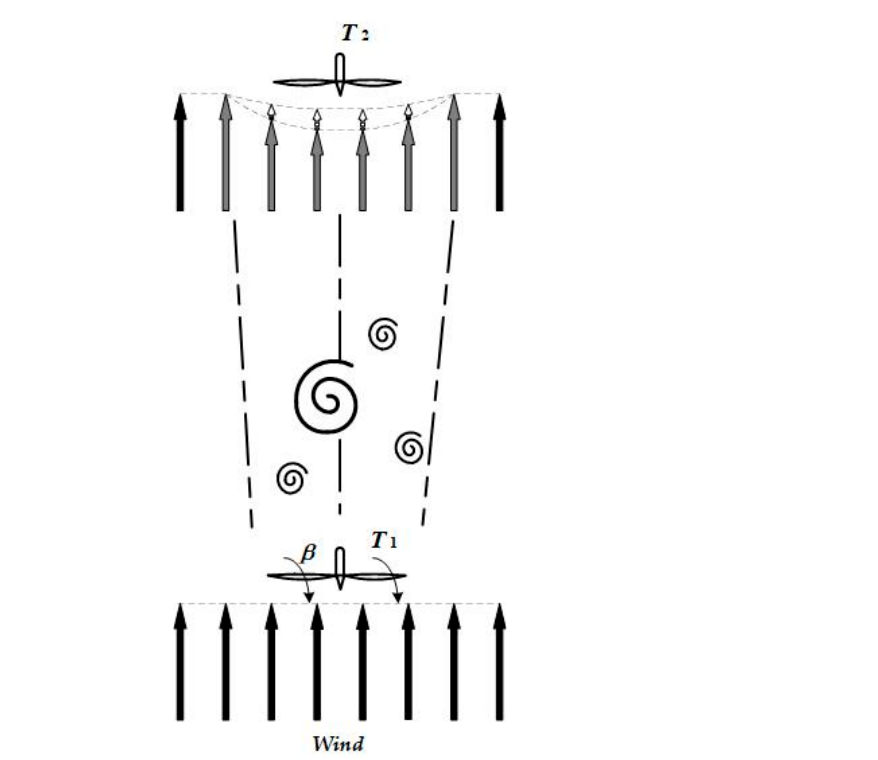
Figure 3. Control diagram of axial induction-based control.